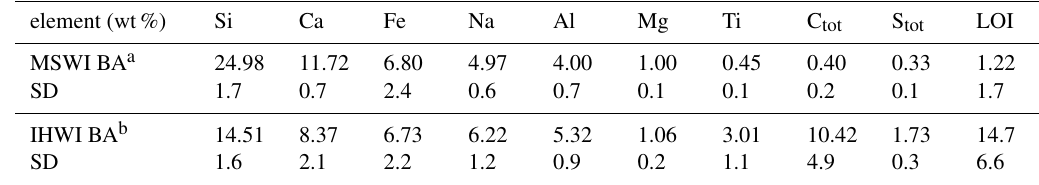
Table 1. Averaged content of major elements in BAs from waste incineration. element (wt%) Si Ca Fe Na Al Mg